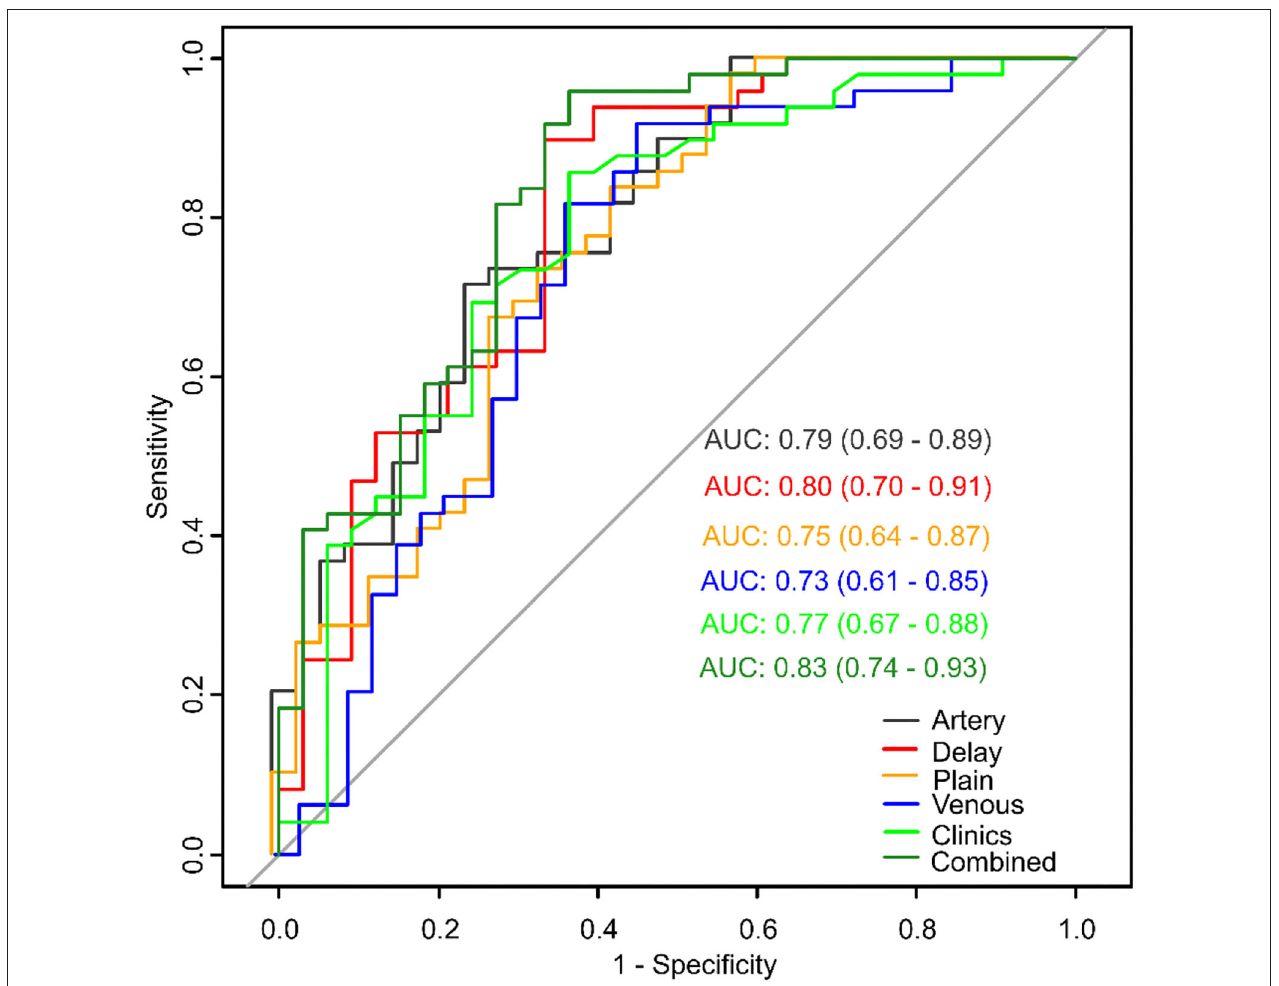
FIGURE 5 | Model comparisons of receiver operating characteristics (ROC) curves for prediction of microvascular